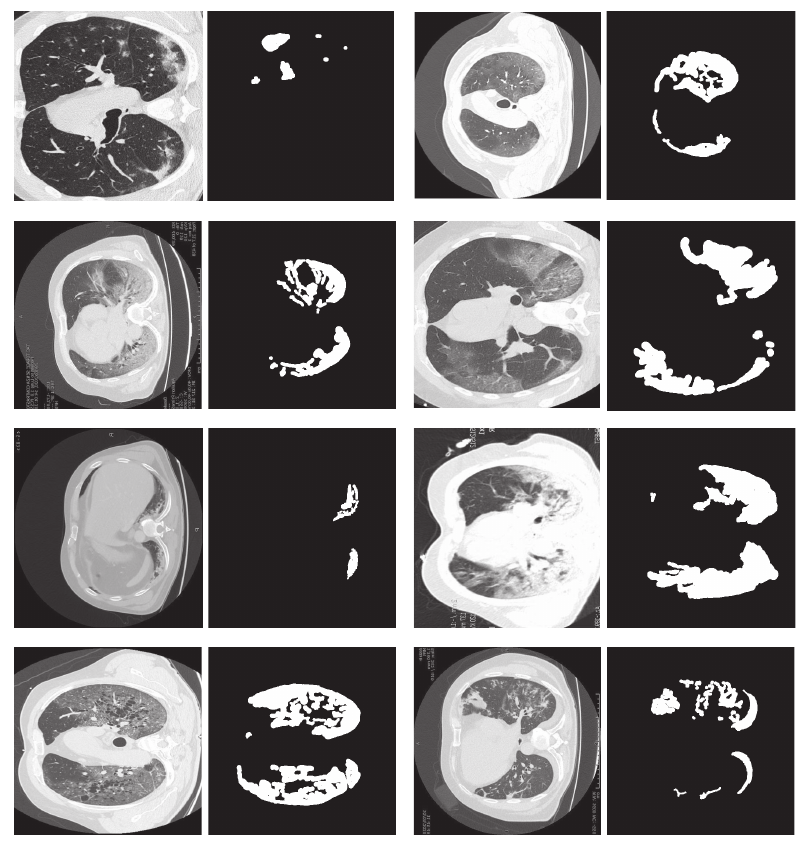
Figure 6. Samples of images of COVID-19 database and their ground truth (a binary image where the white parts represent the area of